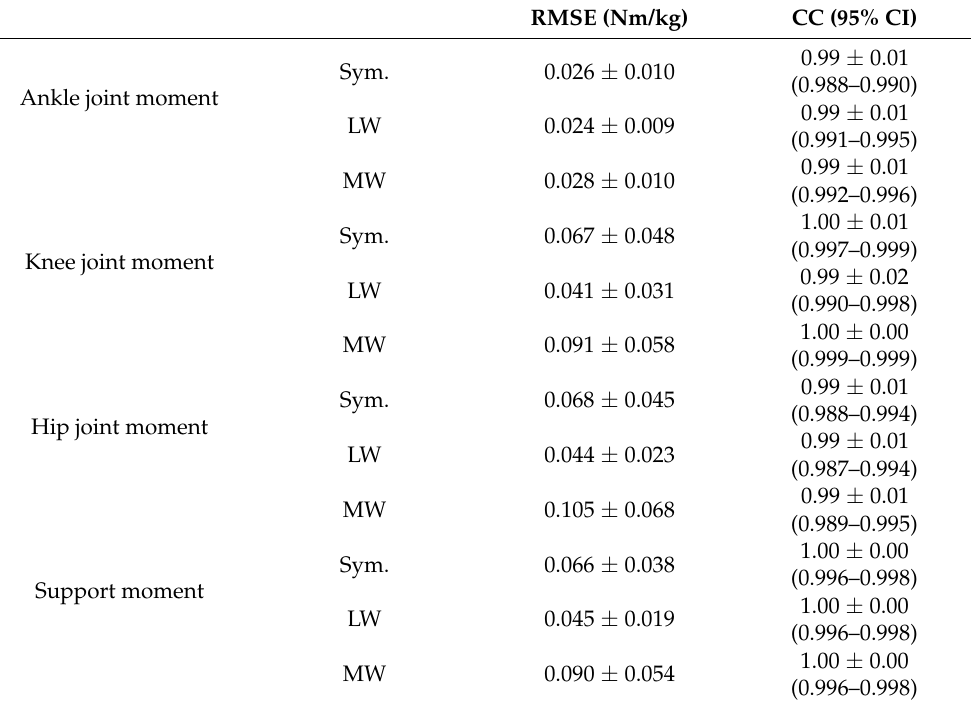
Table 3. Comparison of joint moments and support moment obtained from the proposed system and conventional system with the motion capture